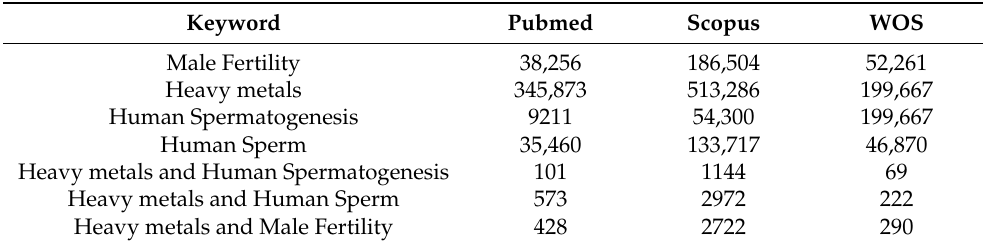
Table 1. Number of publications in each database according to the different keywords utilized after applying the inclusion